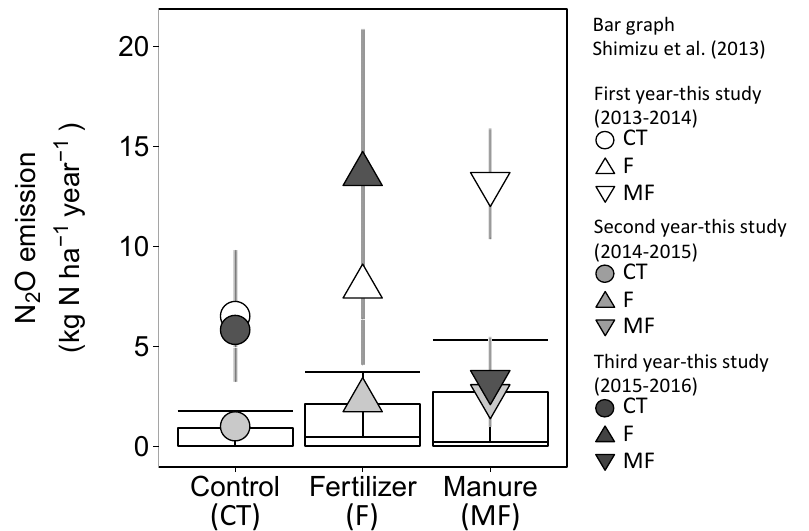
Figure 4. Comparison of annual N 2 O emission in this study and Shimizu et al. [11]. CT is unfertilized control plots ( ○ ); F is chemical fertilizer plots ( △ ); MF is combined manure and chemical fertilizer plots ( ▽ ). Bar graph shows mean value of annual N 2 O emissions from across three permanent managed grasslands on different Andosols in Hokkaido region, Japan, reported by Shimizu et al. [11]. The management method of treatments in this study (CT, F, and MF) is following Shimizu et al. [11] (Control, Fertilizer, and Manure, respectively). Error bar shows standard deviation.